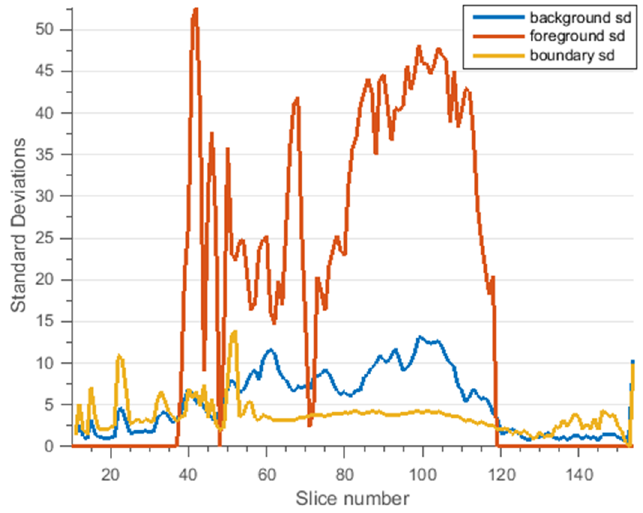
Figure 11. Background, foreground and boundary standard deviations in slices 10–154 in the moderate MS lesion brain data from BrainWeb after pre-processing. Slices with no foreground detected are assigned 0 foreground standard deviation.